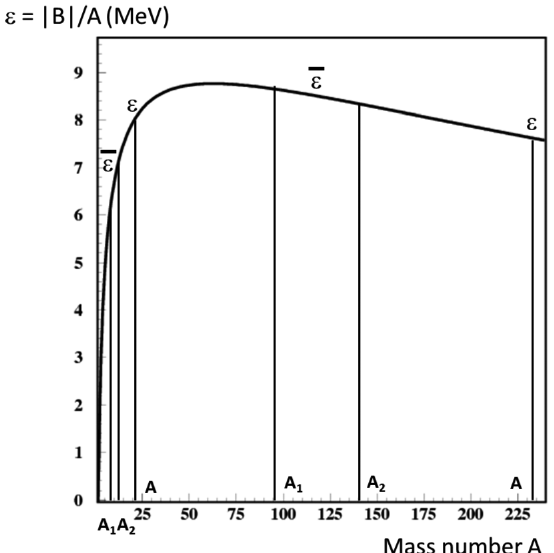
Fig. 1. – Absolute value of binding energy per nucleon (cid:2) , as a function of the mass number A . The figure also illustrates the case of the nuclei of mass number A 1 and A 2 undergoing fusion and merging into a nucleus of mass number A , as well as the case of a nucleus of mass number A undergoing fission and splitting into two fragments of mass number A 1 and A 2 . ¯ (cid:2) is the mass-number-weighted absolute binding energy per nucleon in both the fusion and fission cases . (see sect. 1